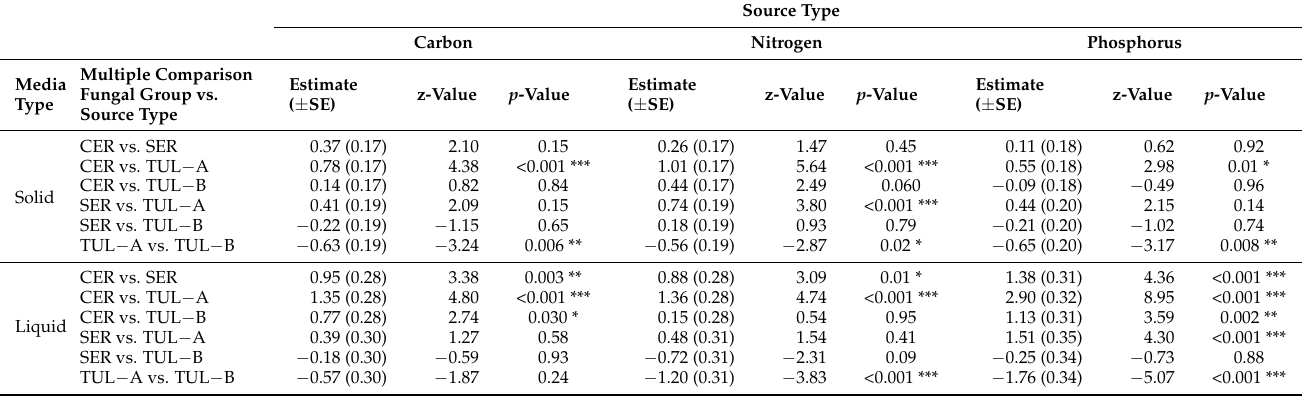
Table 2. Generalized linear mixed-effect models (GLMMs) comparing fungal biomass grown on three source types (carbon, nitrogen, phosphorus) in both solid and liquid media. Tukey post-hoc multiple comparison tests of the four fungal groups: Serendipitaceae (SER), Ceratobasidiaceae (CER), Tulasnellaceae (two clades TUL-A and TUL-B), within each source type; * p < 0.05, ** p < 0.01, *** p <